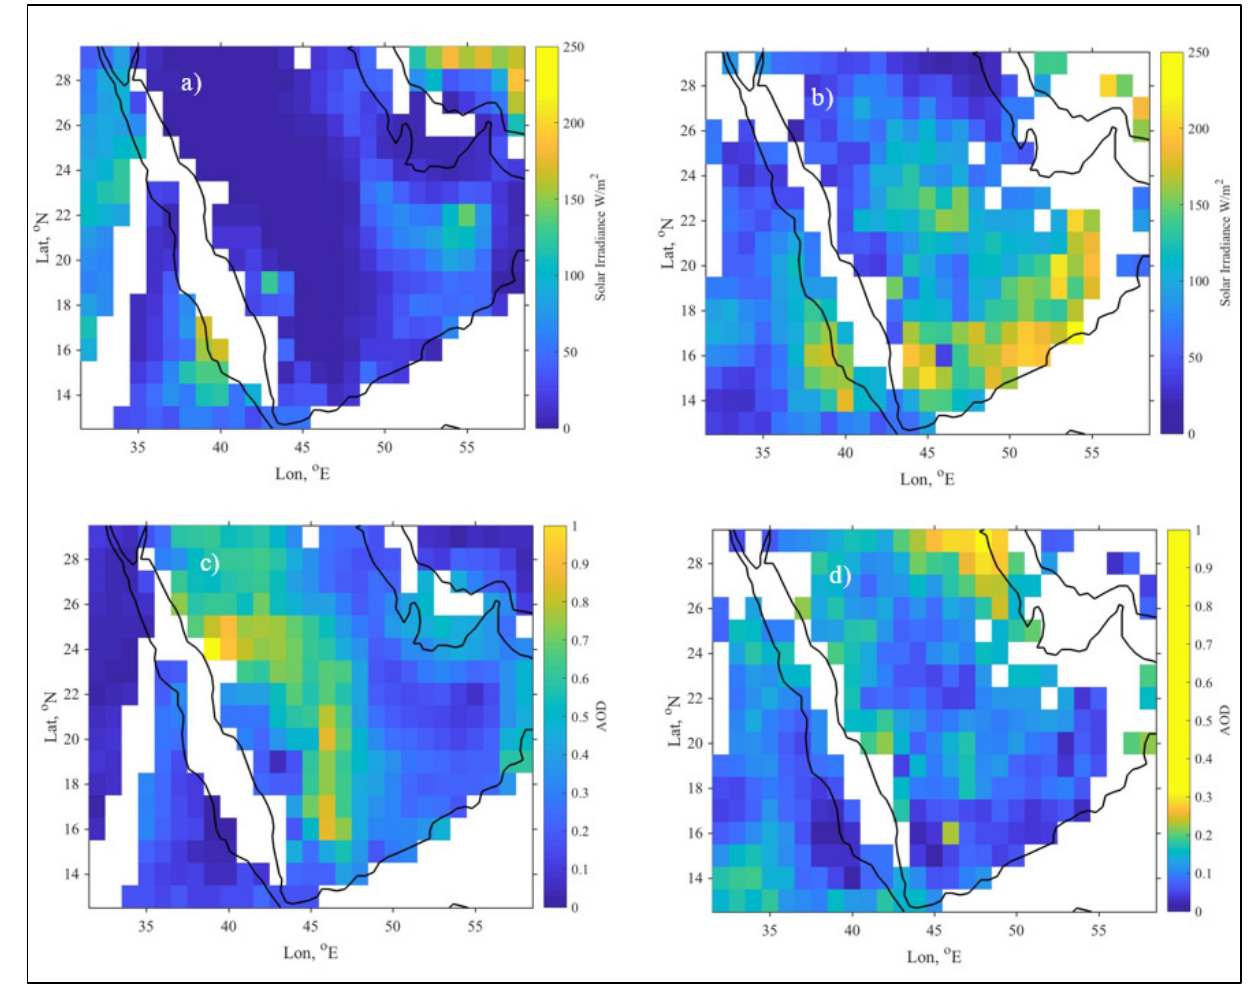
Figure 12. Effect of a major dust event, on solar irradiance over the AP on ( a ) 20 March 2012, ( b ) 4 April 2012; and on AOD for ( c ) 20 March 2012, and ( d ) 4 April 2012.